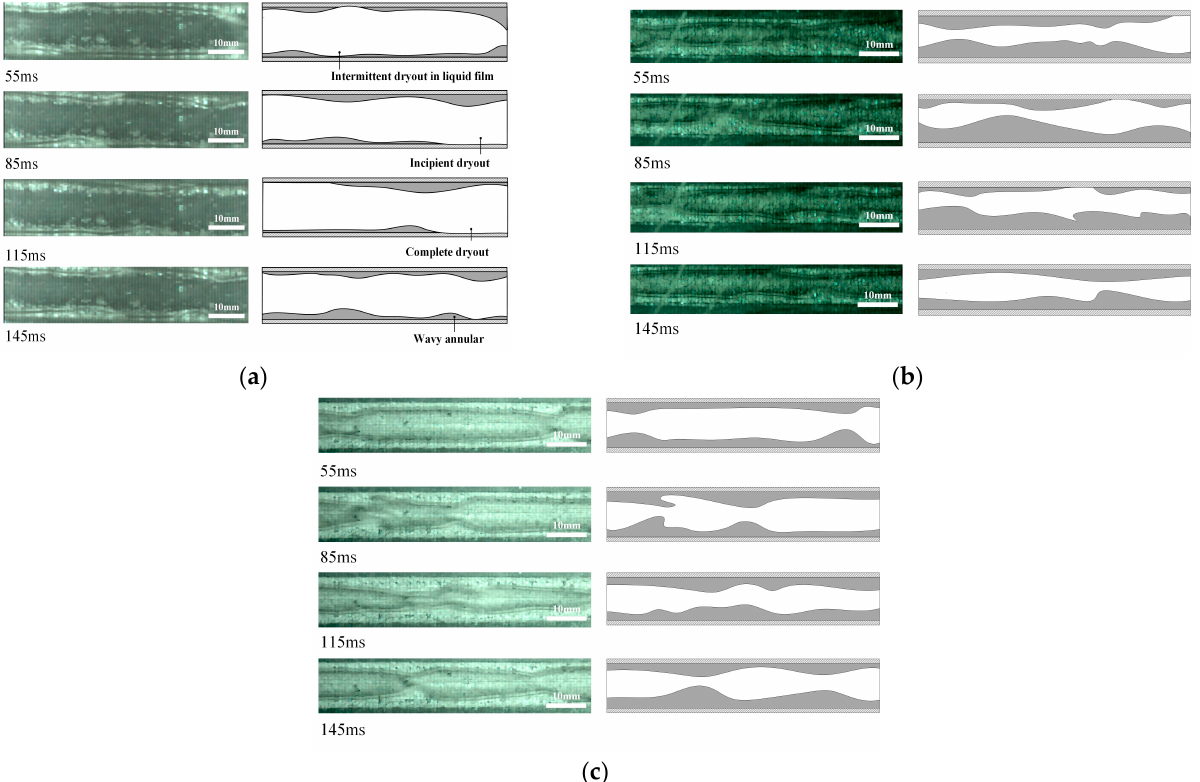
Figure 7. Comparison of flow patterns in microchannels with different wettability under G = 950 kg/(m 2 s), x in = 0.066, q = 46 kW/m 2 for ( a ) Untreated surface microchannel, ( b ) Hydrophilic microchannel, ( c ) Super-hydrophilic microchannel.